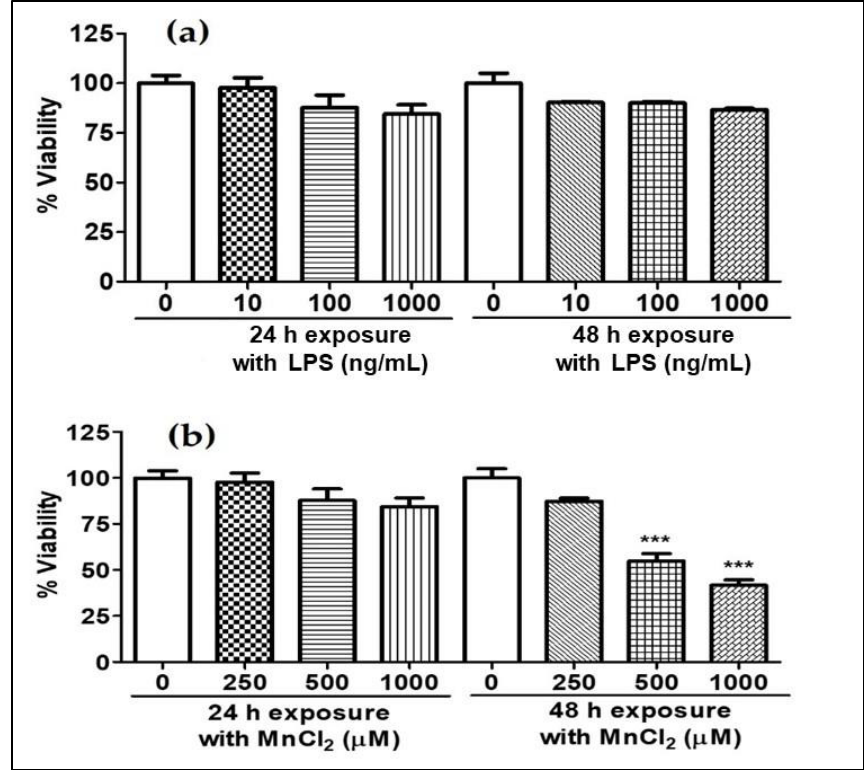
Figure 1. Effect of MnCl 2 and LPS on viability of N2a cells, ( a ) %viability of N2a cells post-LPS (10, 100 and 1000 ng/mL) exposure for 24 and 48 h, ( b ) %viability of N2a cells post-MnCl 2 (250, 500 and 1000 µM) exposure for 24 and 48 h. Data represented as mean ± SEM. *** p < 0.0001 vs. control group.